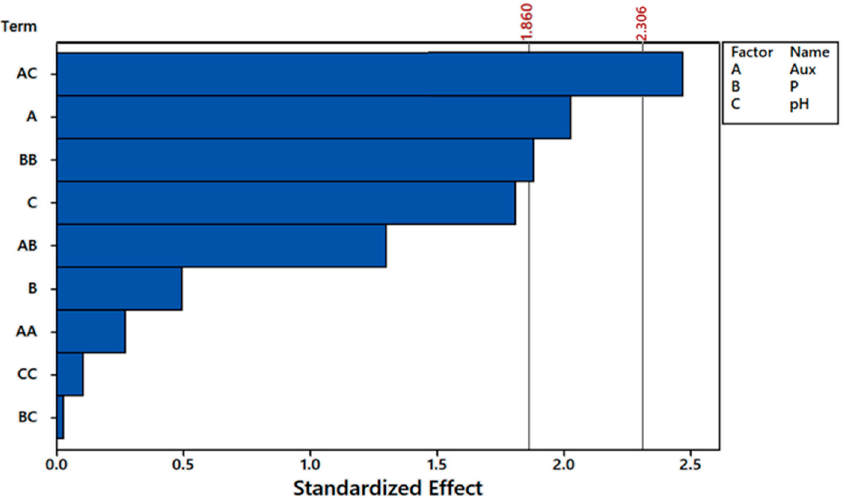
Figure 7. Pareto chart of full quadratic model at α = 10% (1.860) and α = 5% (2.306) for fluoride removal per dry mass of plant in the CCRD experiment. Auxin (A), phosphorus initial concentration (B), and pH (C). The bars behind the thresholds of α values represent factors that were not significant to the response variable.